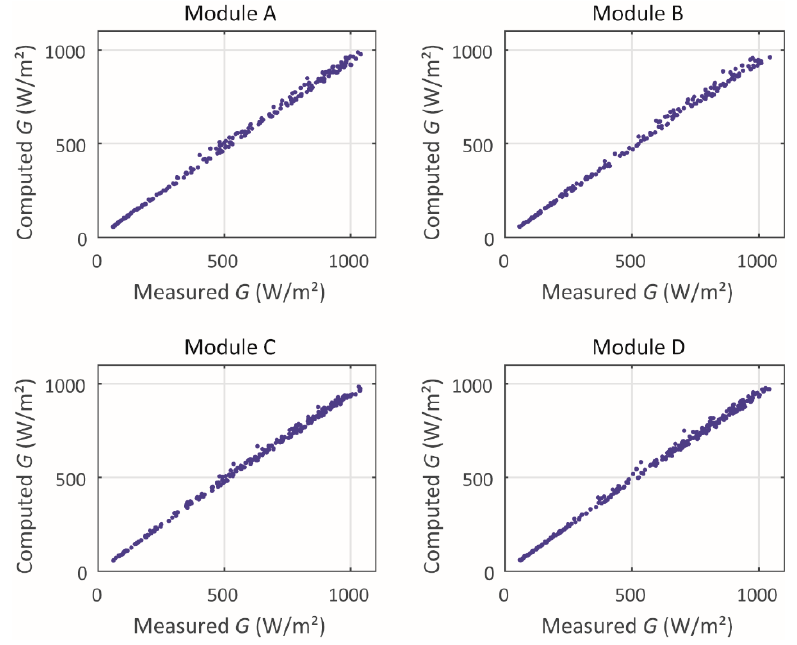
Figure 2. Irradiance correlation.